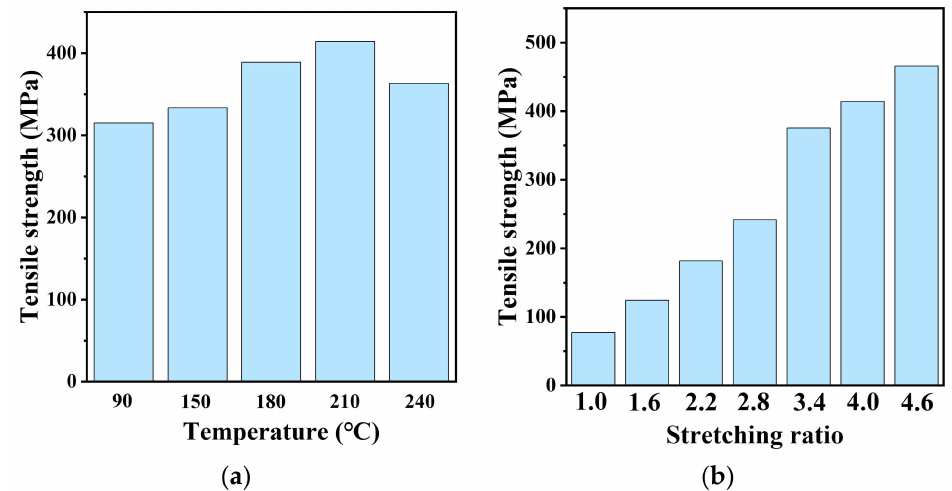
Figure 2. Tensile strengths of samples with ( a ) different stretching temperatures; ( b ) different stretching